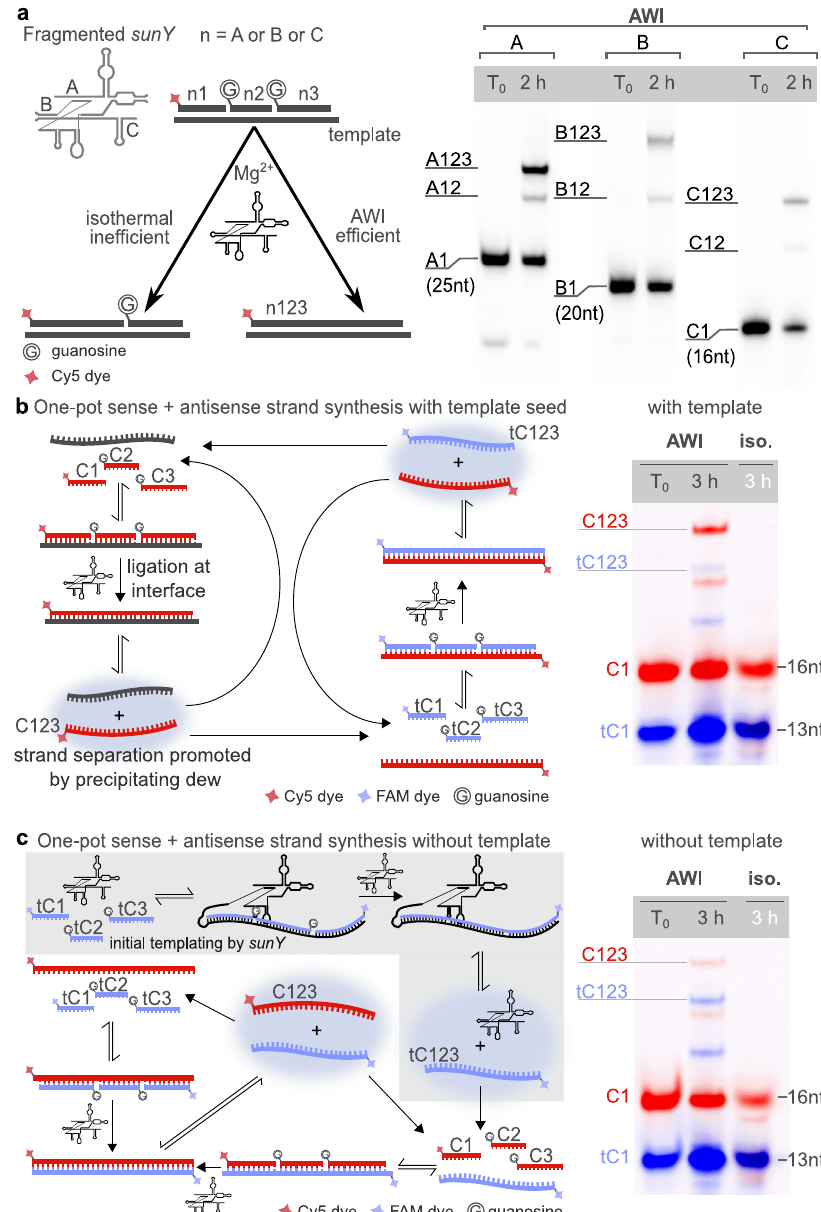
Fig. 2 | Complete replication cycles of sunY fragments. a Illustration (left) and PAGE analysis (right) of separately performed template-dependent ligations of the three sunY fragments A123, B123, and C123. Lanes show reactions before (T 0 ) and after 2h of incubation. b – c Full replication cycle of fragment C123. Replication proceeds vial ligation of the RNA substrates for the sense strand (C1, C2, C3-Cy5,